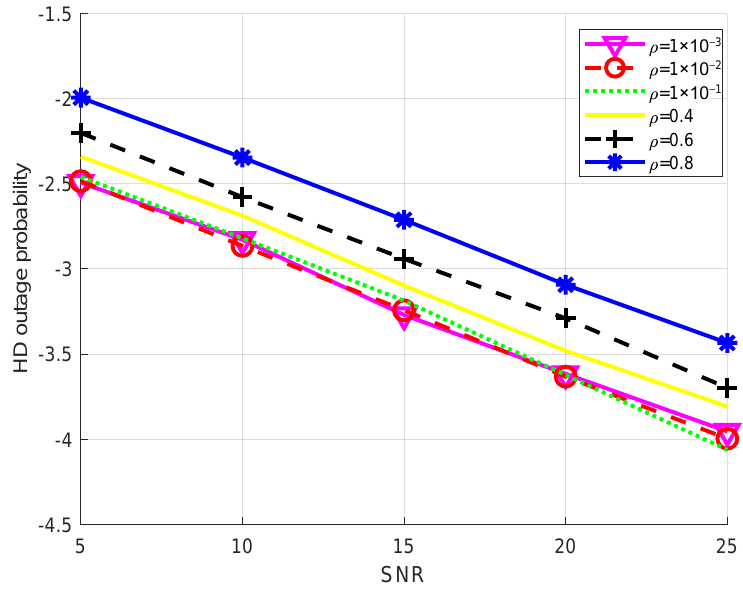
Figure 7. Half -duplex outage probability comparison. At the same time, we assumed that the distance between the source node and desti- nation node was 1. We compared the capacity of the half-duplex system when the direct distance d between the relay node and source node changes, as we can see in Figure 8. We found that the smaller the PS factor, the closer the relay node to destination node, and the higher the capacity